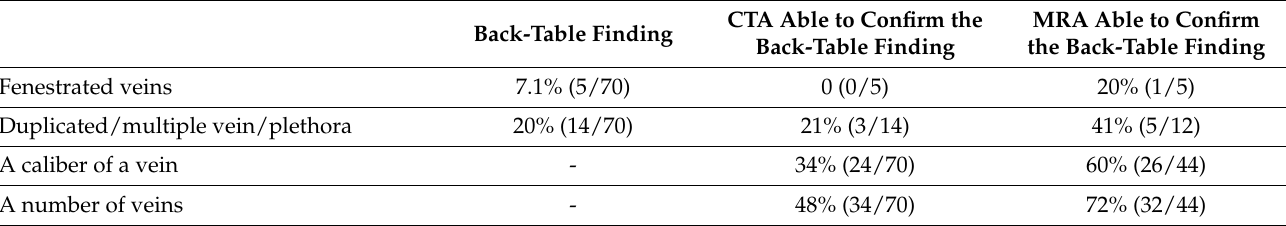
Table 3. A comparison of CTA vs. MRA concerning the evaluation of quality and quantity of